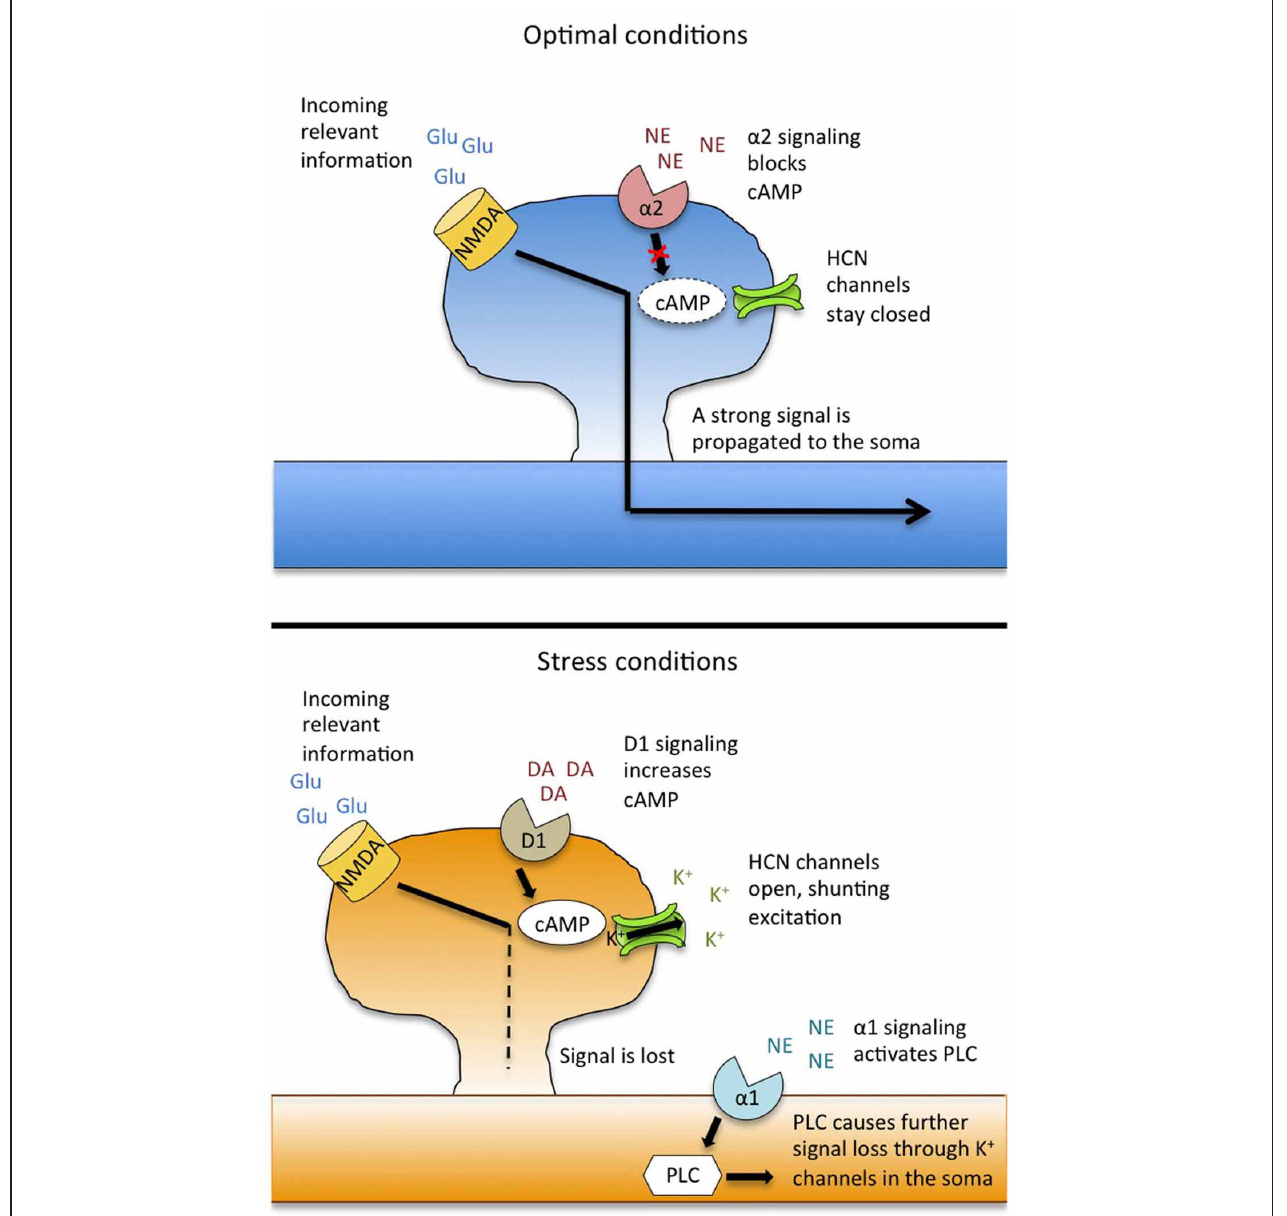
FIGURE 1 | Model for catecholamine modulation and stress-induced impairment of working memory. Under stress-free conditions ( top ), the noradrenergic alpha-2 receptor drives activity in the prefrontal cortex by suppressing cAMP levels and strengthening the signal from incoming information. Under stress ( bottom ), overstimulation of the dopamine D1 receptor activates cAMP, causing HCN channels to open, resulting in a shunting of incoming excitation. Additionally, stimulation